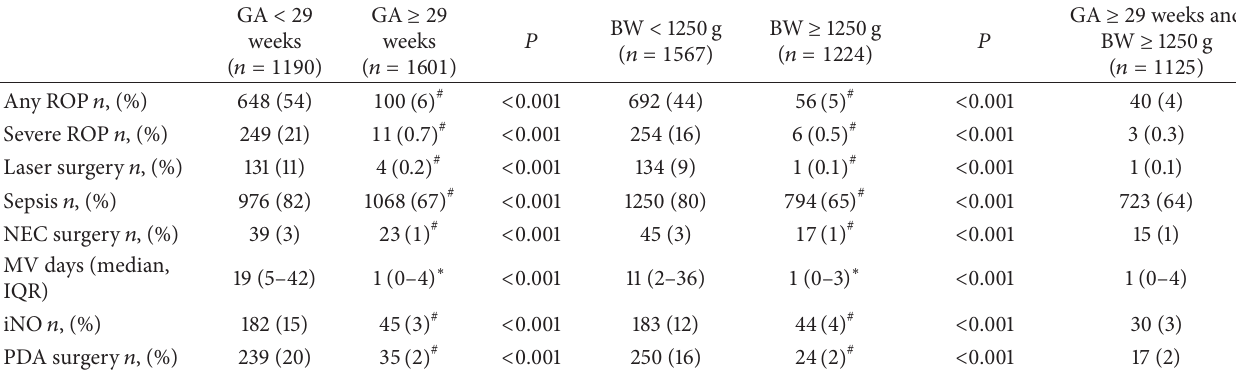
Table 1: Clinical characteristics of study population stratified by gestational age and birth